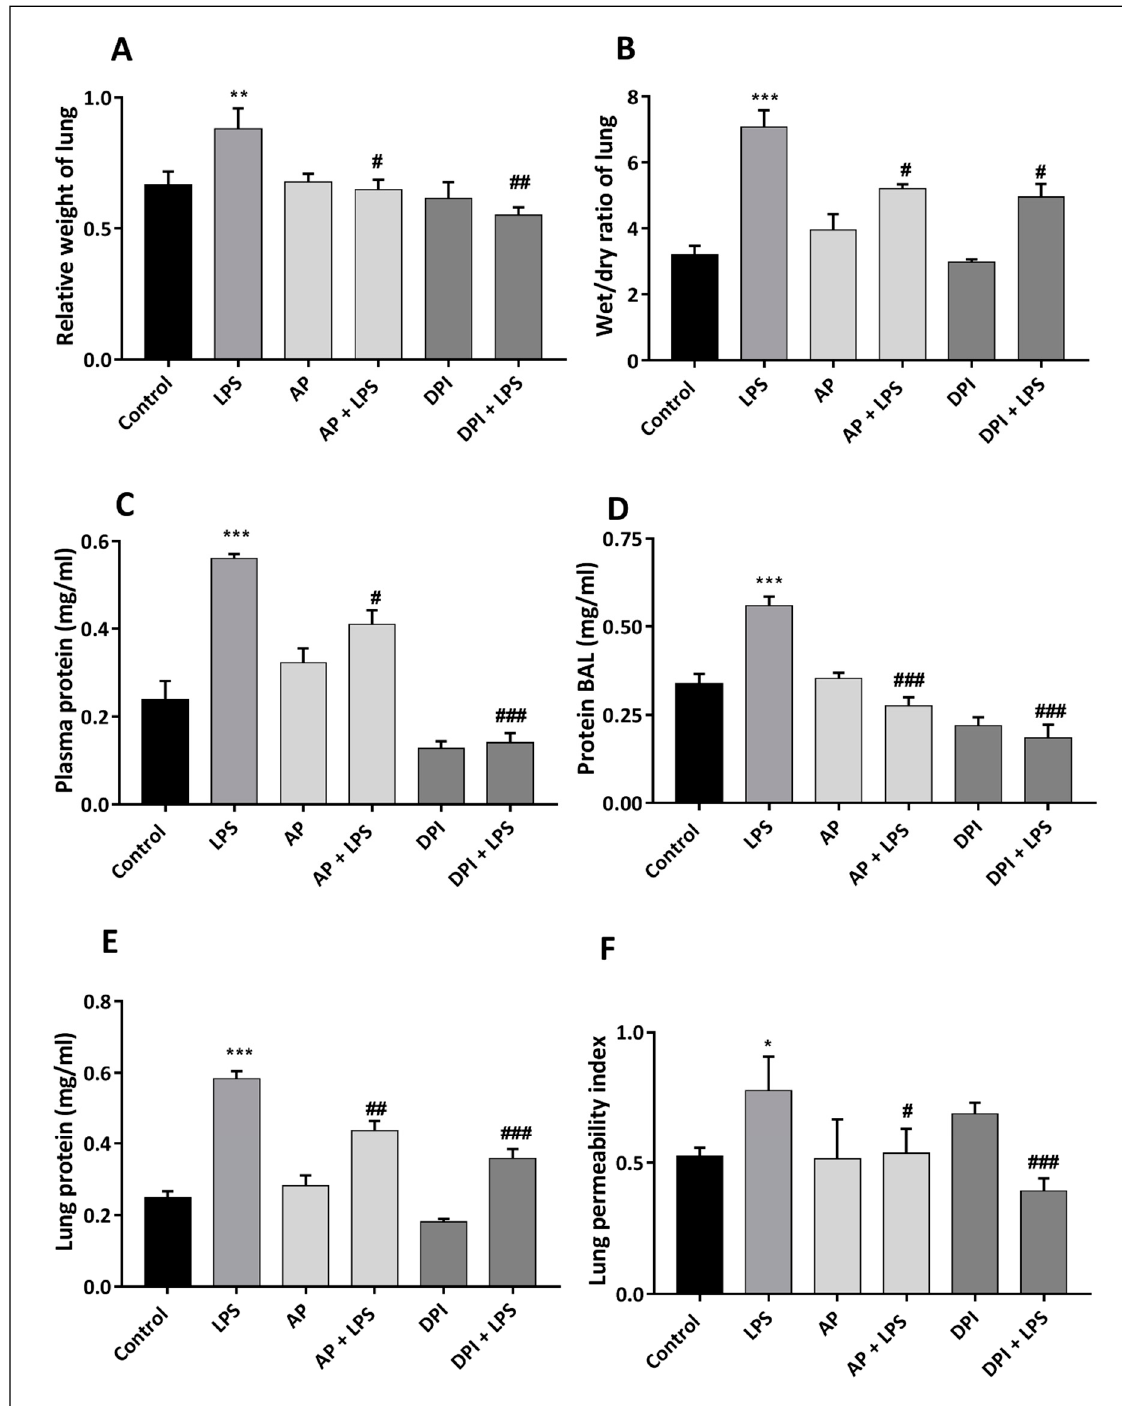
Figure 4. Effect of apocynin (AP) and DPI on relative weight of lung ( A ), wet/dry ratio of lung ( B ), total protein in plasma ( C ), proteins in BAL ( D ), lung protein ( E ) and lung permeability index ( F ) during the induction of acute lung inflammation by LPS, the results are presented in the form of means ± S.E.M with n = 5 with * p < 0.05, ** p < 0.01 and *** p < 0.001 compared to the control group and # p < 0.05, ## p < 0,01 and ### p < 0.001 compared to the LPS group.